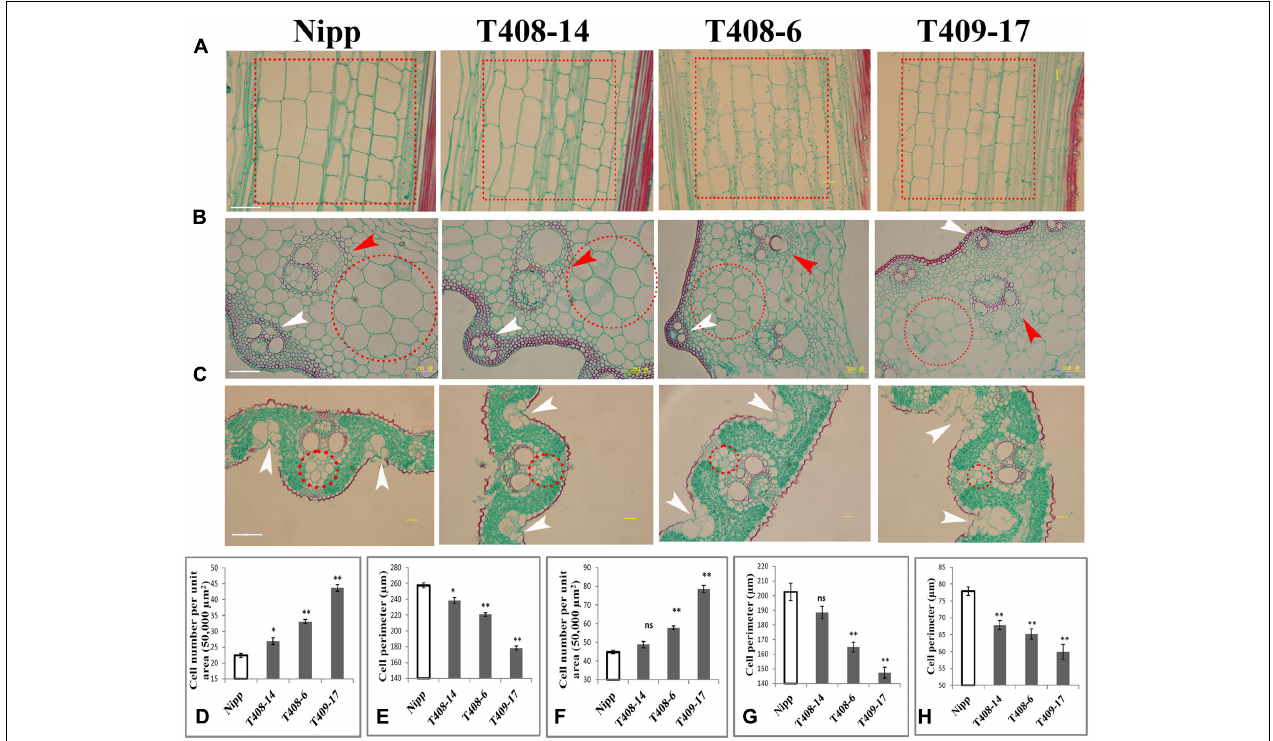
FIGURE 4 | OsGIF1 regulation of cell size to control rice organ size. (A–C) Paraffin section analysis of the stems and leaves of KO plants. (A) Longitudinal section of stem internode; dotted boxes in red indicate the major cell types selected for cell counting and measuring. (B) Cross section of stem internode. Red arrow heads indicate inner vascular bundles, and white arrow heads indicate outer vascular bundles. Dotted circles in red indicate the major cell types selected for cell counting and measuring. (C) Cross section of leaves. White arrow heads indicate bulliform cells. Dotted circles in red indicate the major cell types selected for cell counting and measurement. The first internode from the bottom and the middle region of the flag leaf of all plants were collected for observation. Scale bars (50 µ m) are shown in Nipp. (D–H) Cell number and size determinations. (D) Cell number per unit area in A ; (E) , cell size in A ; (F) , cell number per unit area in B ; (G) , cell size in B ; (H) , cell size in C . For cell numbers (per unit area) counting, a total area of 50,000 µ m 2 for each sample was investigated. For cell volume determination, 10 representative cells within the dotted circles/boxes regions were selected for cell size measuring. Values are all shown as mean ± SEM ( n = 3). Asterisks indicate significant differences between the WT and KO plants as determined by Student’s t -test: ns, not significant; ∗∗ p ≤ 0.01; ∗ p ≤